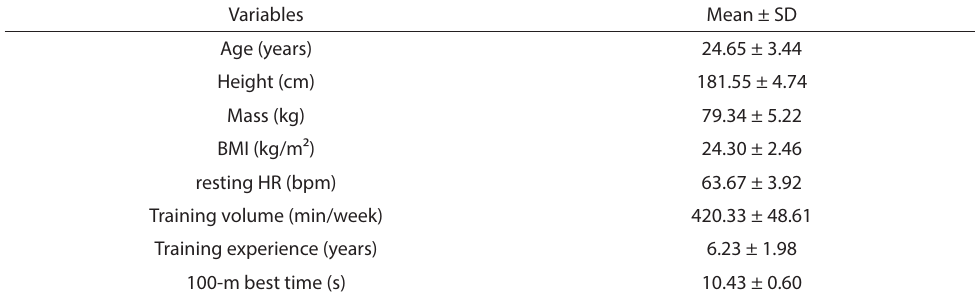
Table 1. Participants’ demographic